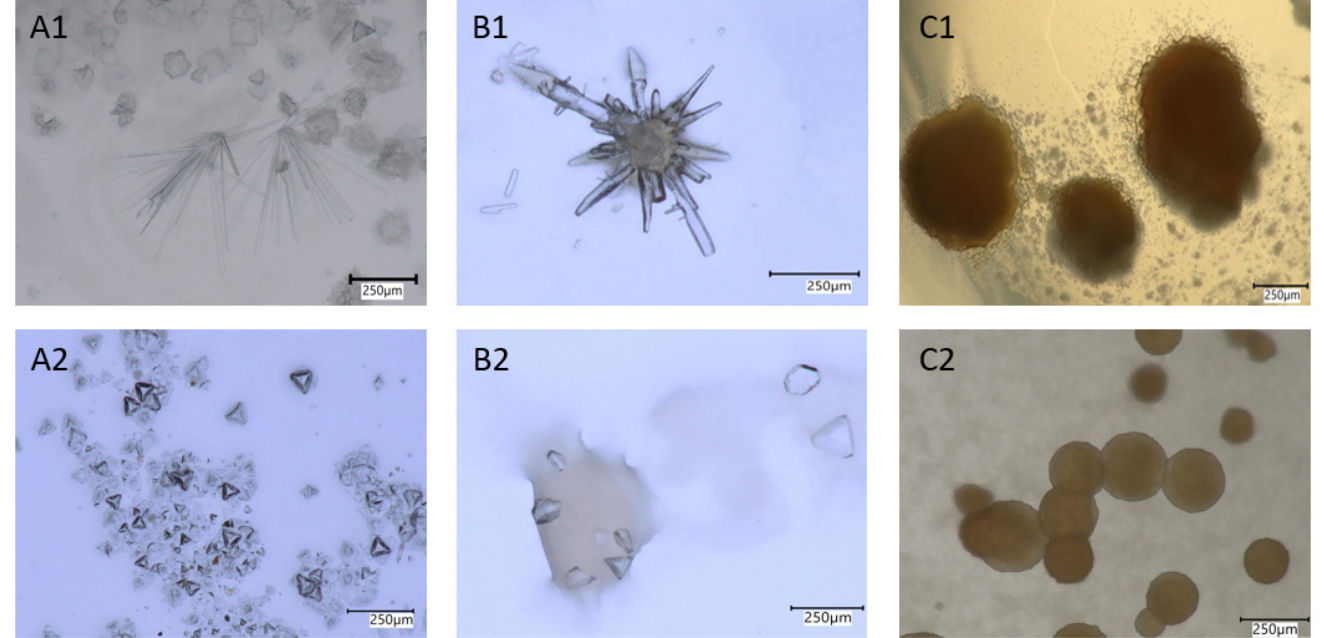
Figure 4. Minerals formed on Cs- ( A , B ) and Sr- ( C ) containing media. ( A1 ) Needle-like aggregates and botryoidal crystals formed with Cs 2 SO 4, ( A2 ) tetrahedrons formed with Cs 2 SO 4, ( B1 ) close-up of needle aggregates and ( B2 ) aggregates, formed with CsCl, ( C1 ) brown-colored aggregates, and ( C2 ) singletons formed with SrCl 2 .